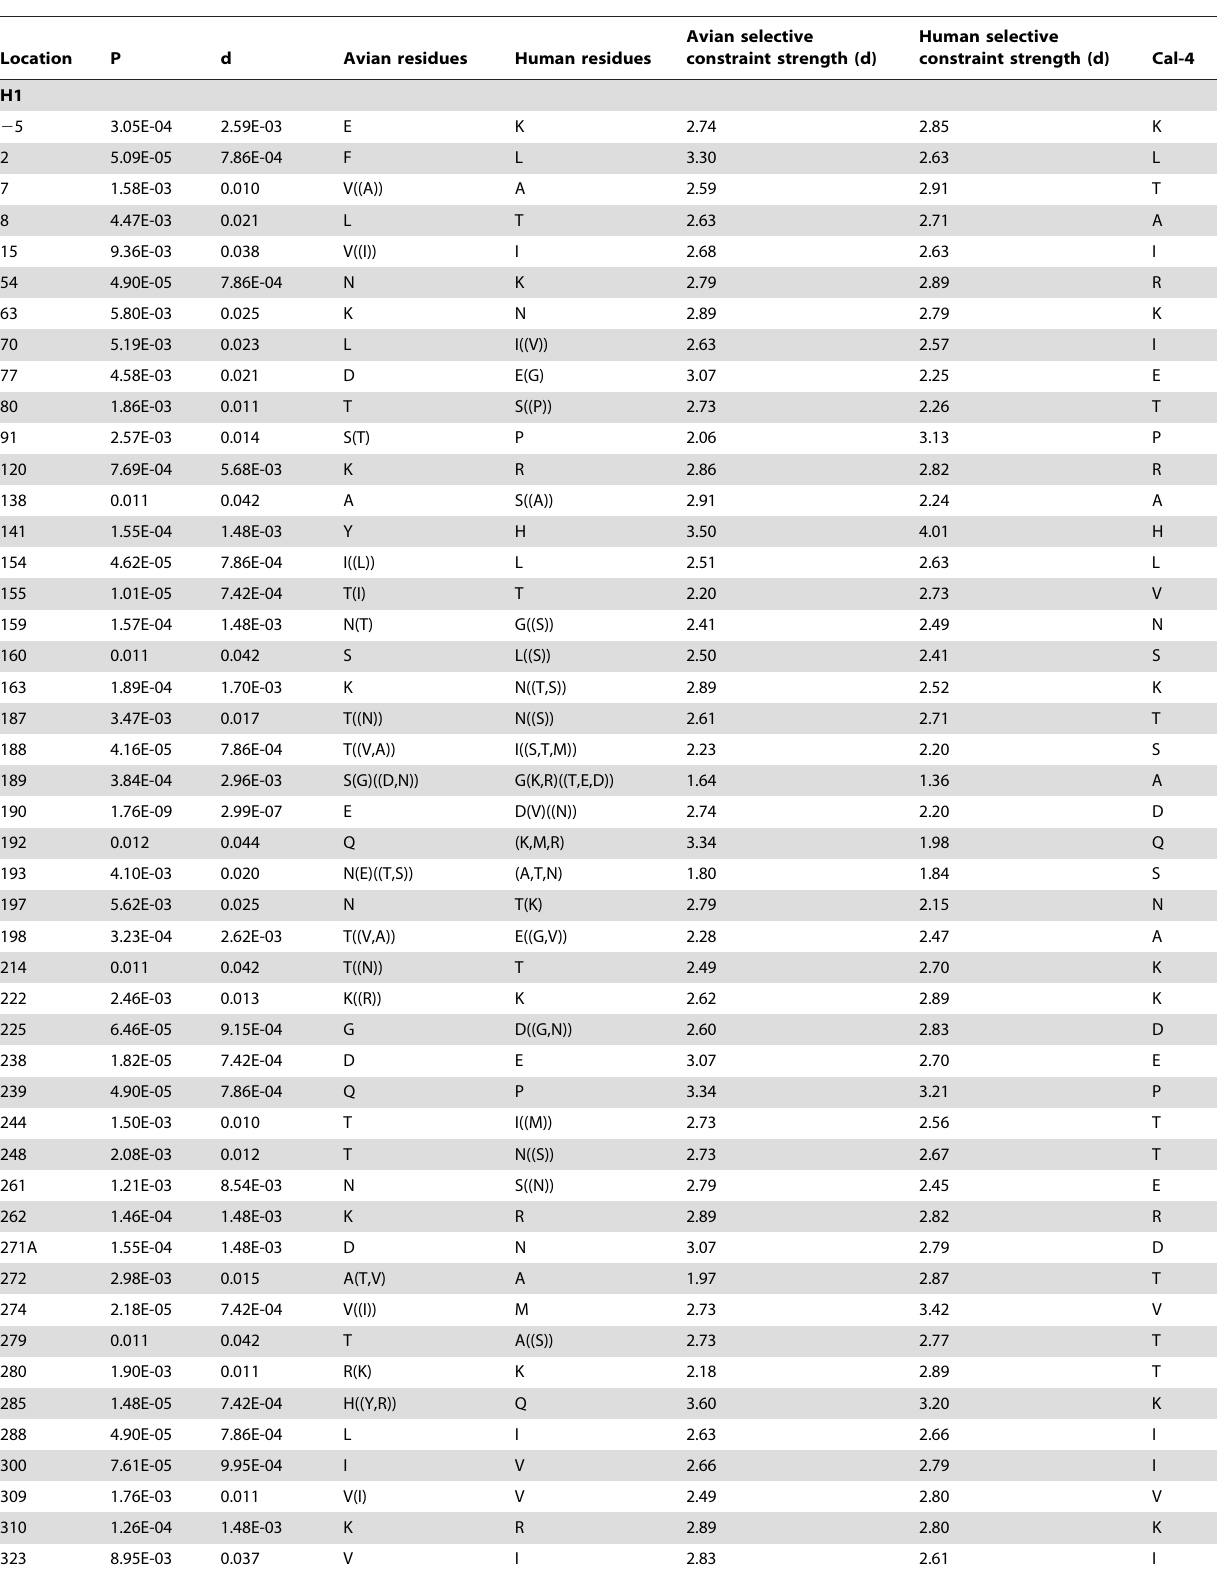
Table 1. Sites identified as undergoing changes in selective pressure during host shifts from birds to humans.